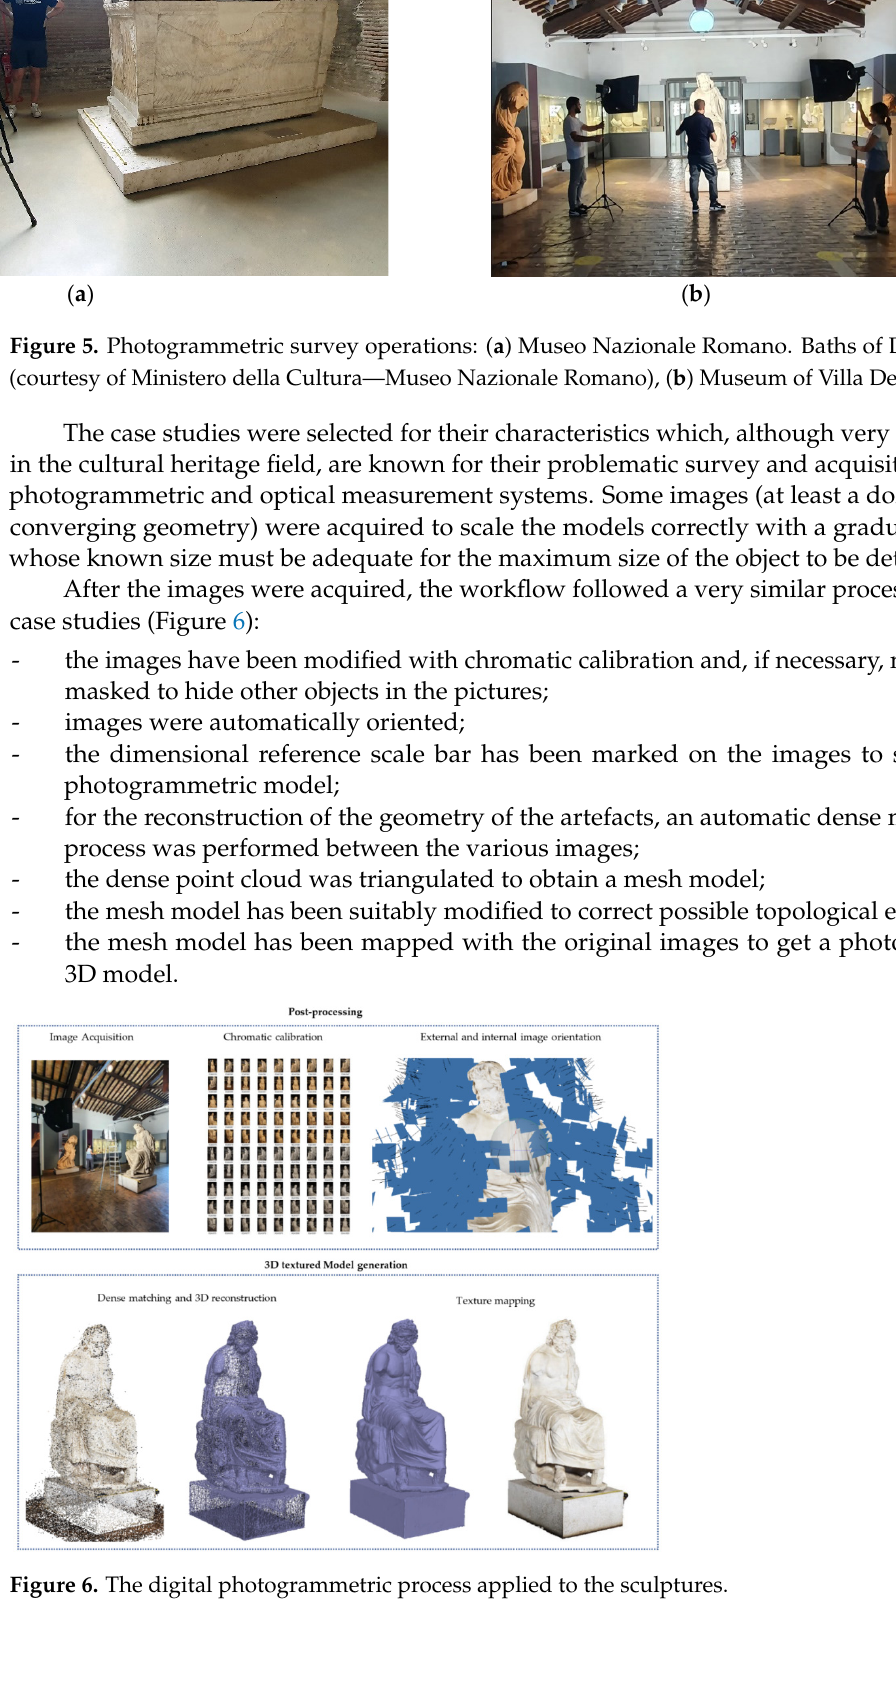
Figure 7. The model and 3D visualisation of Zeus’ sculpture: from the mesh model to the textured NURBS model. On the other hand, VR takes the user directly into a virtual fictional world. The advantages of the AR application are the enrichment of human sensory perception